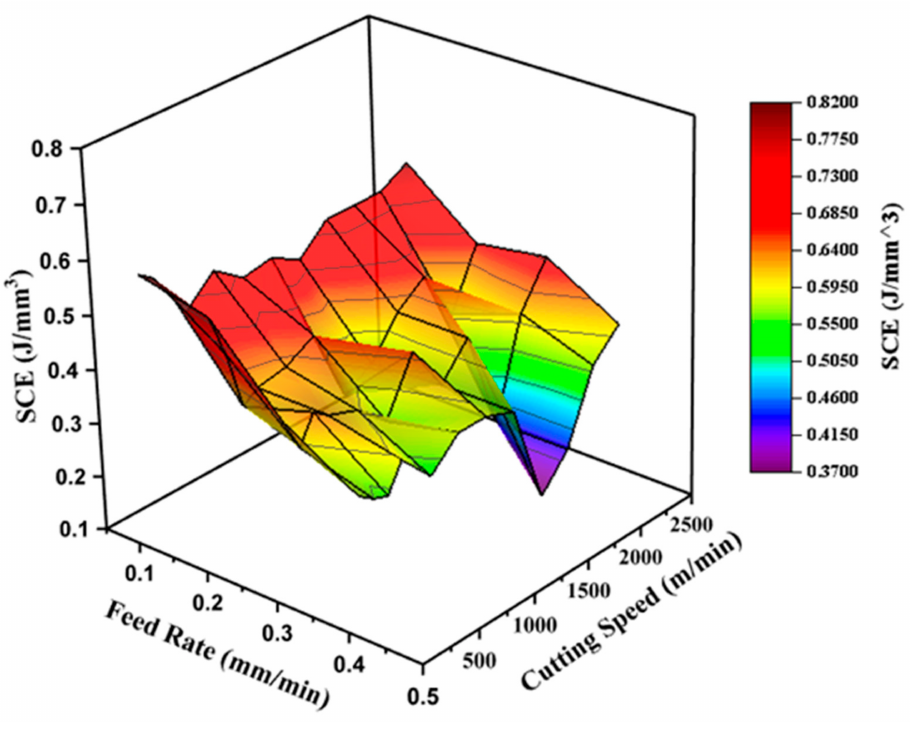
Figure 13. Effect of cutting speed-feed on SCE in three machining regions.